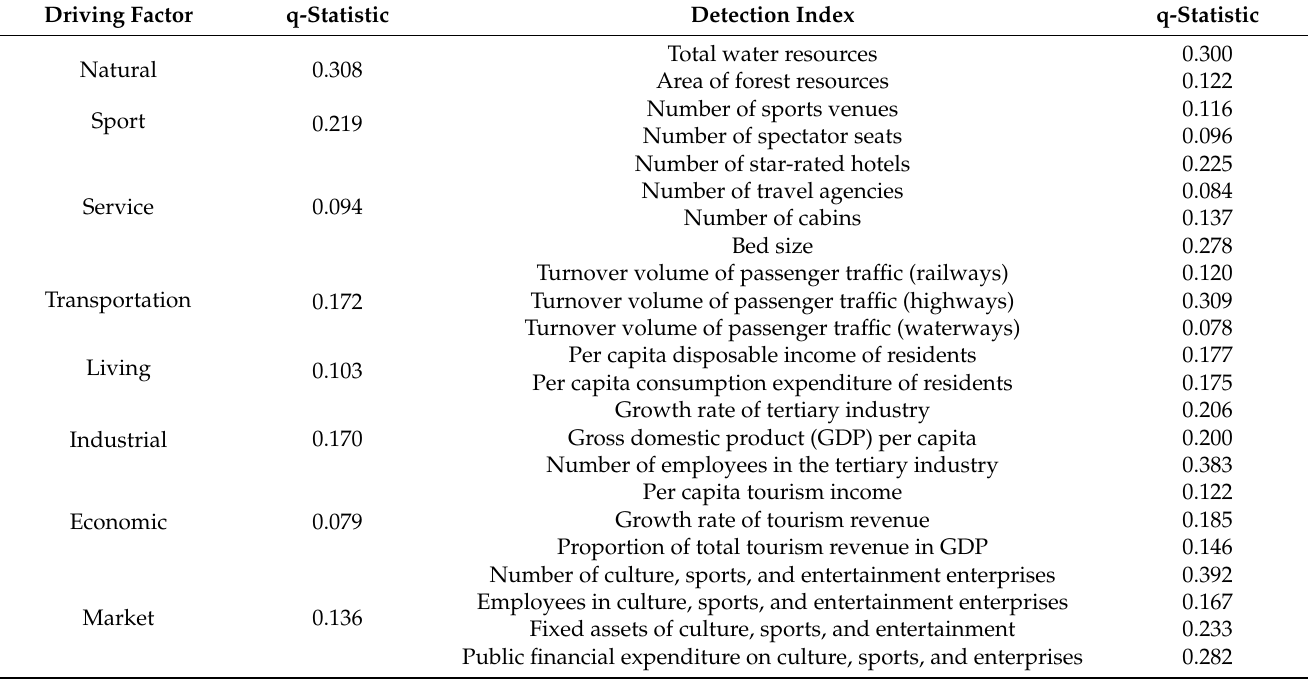
Table 2. Detection results of factors affecting the spatial distribution of sports tourism resources in